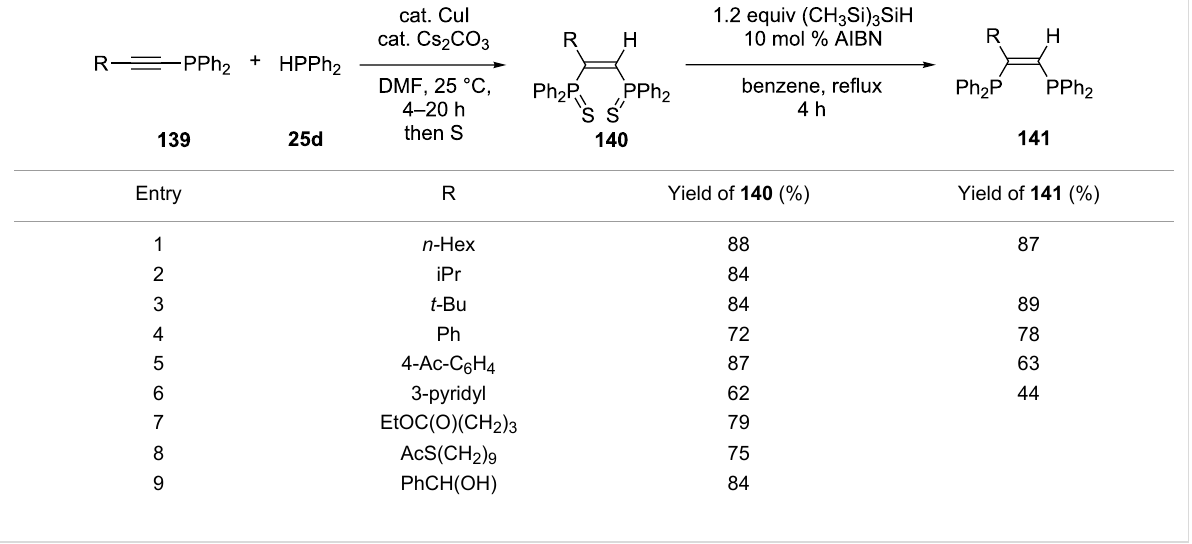
Table 16: Copper-catalyzed hydrophosphination of 1-alkynylphosphines 139